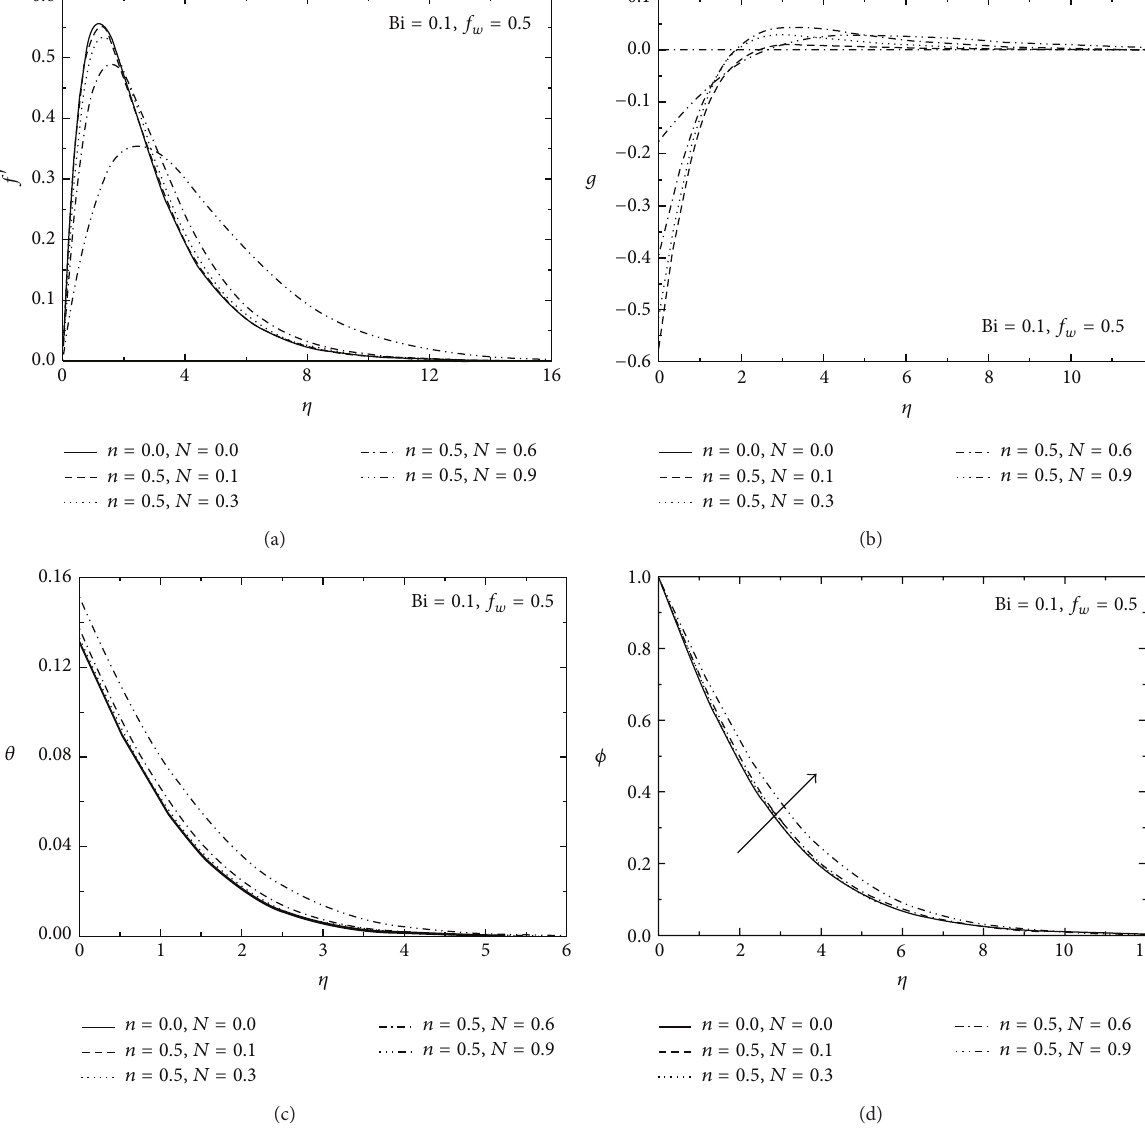
Figure 2: Effect of 𝑁 on (a) velocity, (b) microrotation, (c) temperature, and (d) concentration profiles.